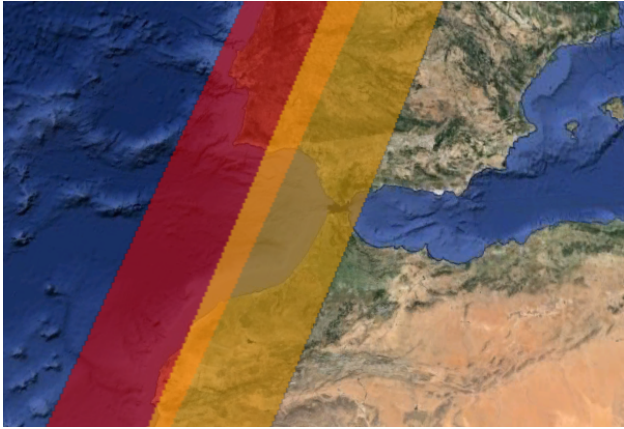
Figure 2. Example of Sentinel-2 tracks: in red, the acquisitions of Day D; in yellow, those of Day D + 7 (with one satellite) or Day D + 2 (with 2 satellites). Background image c (cid:13) 2015 Google